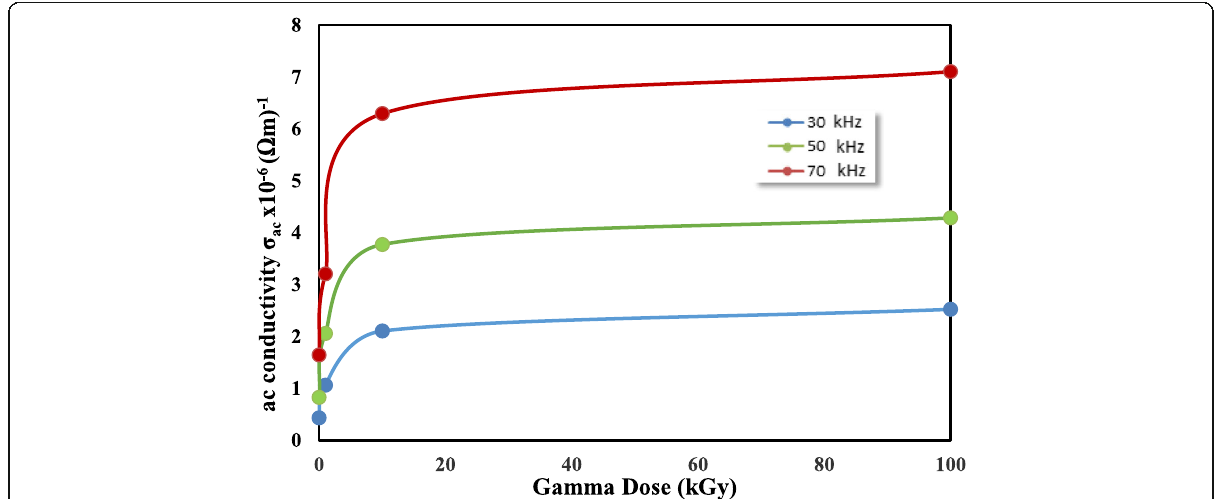
Fig. 6 The ac conductivity of the Makrofol DE 1-1 polymer versus radiation doses at different frequency